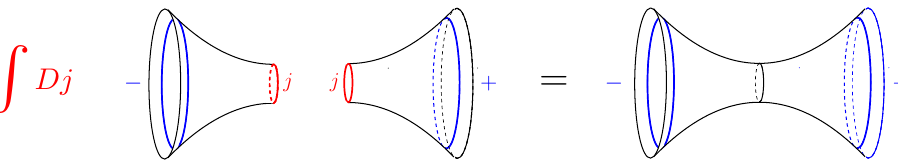
Figure 6: Emergence of the wormhole from the average over boundary